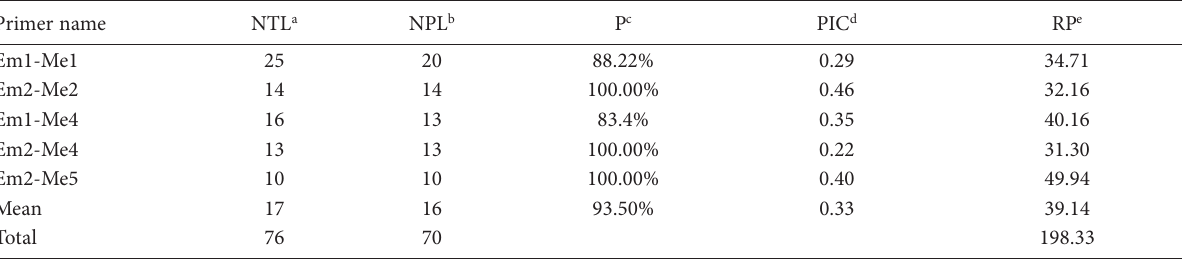
Table 2. SRAP primer information and